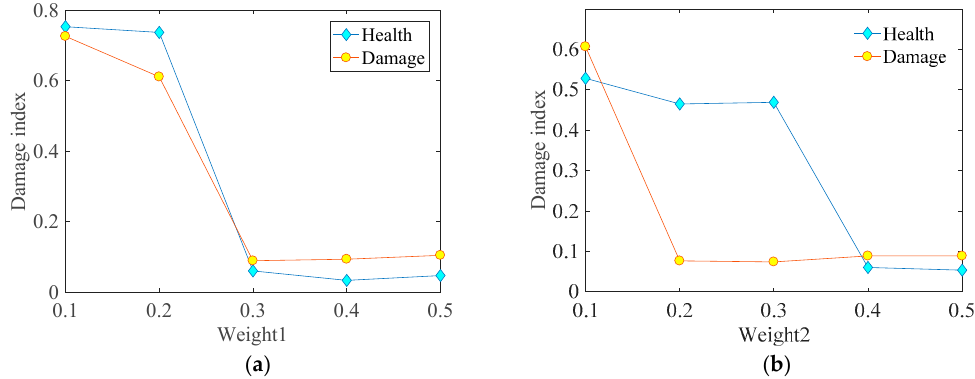
Figure 6. Damage index (DI) values change with ( a ) weight1 and ( b ) weight2 in the health and damage condition.